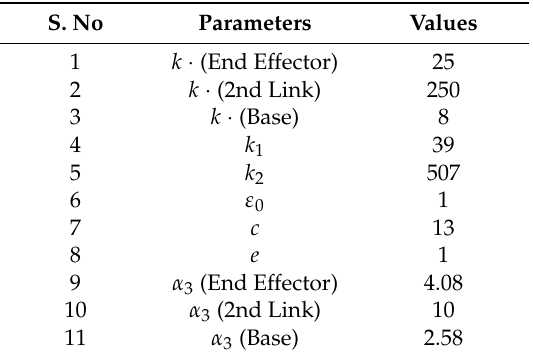
Figure 10. Comparison between PID and SMCSPO.